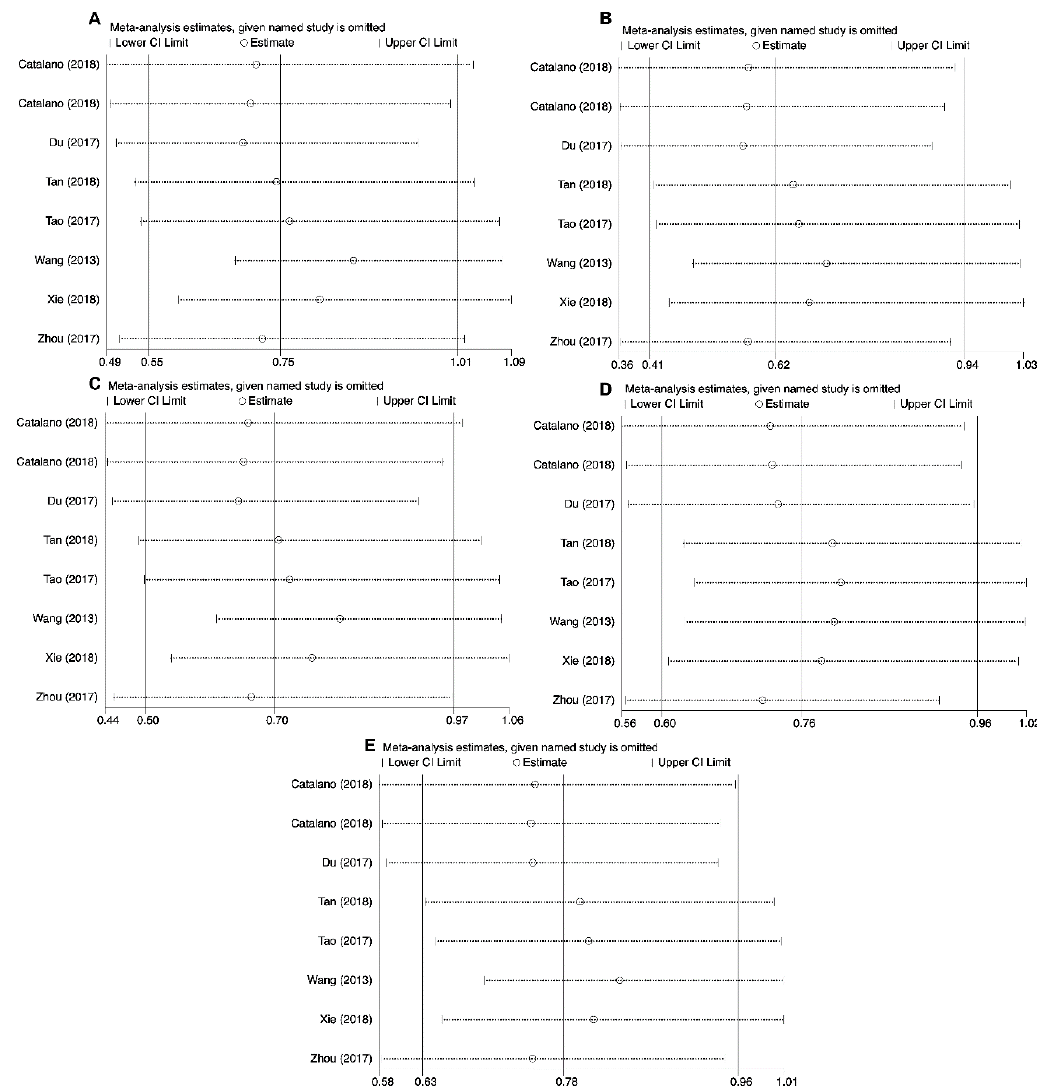
Figure 7. Sensitivity analyses for studies on PD-L1 rs4143815 polymorphism and cancer susceptibility for CG vs. GG ( A ), CC vs. GG ( B ), CG + CC vs. GG ( C ), CC vs. CG + GG ( D ), and C vs. G ( E ).